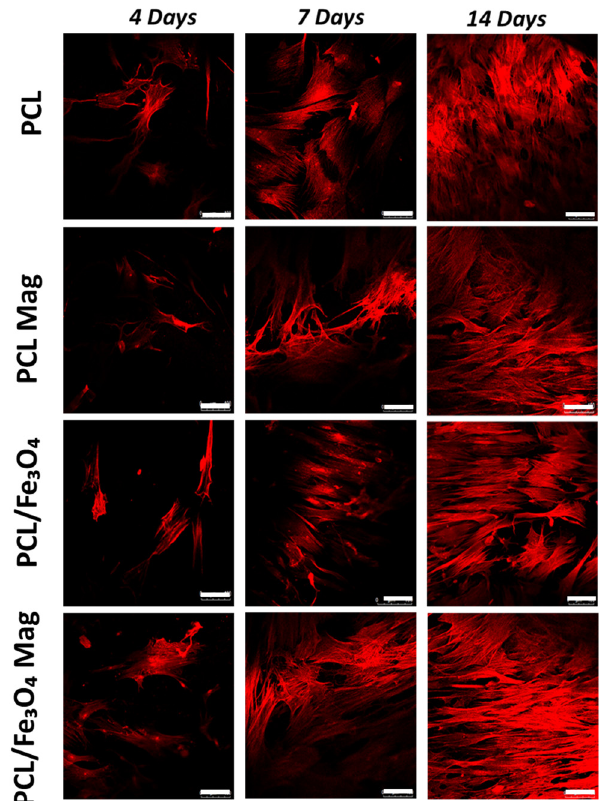
Figure 5. Confocal laser scanning microscopy (CLSM) analysis on cell-laden substrates at different time points. Images of rhodamine phalloidin-stained actin filaments (red). (left column) From top to bottom: PCL, PCL Mag, PCL/Fe ₃ O ₄ , and PCL/Fe ₃ O ₄ Mag at 4 days. (middle column) From top to bottom: PCL, PCL Mag, PCL/Fe ₃ O ₄ 80/20, and PCL/Fe ₃ O ₄ 80/20 Mag at 7 days. (right column) From top to bottom: PCL, PCL Mag, PCL/Fe ₃ O ₄ 80/20, and PCL/Fe ₃ O ₄ 80/20 Mag at 14 days. Scale bar: 100 μ m.